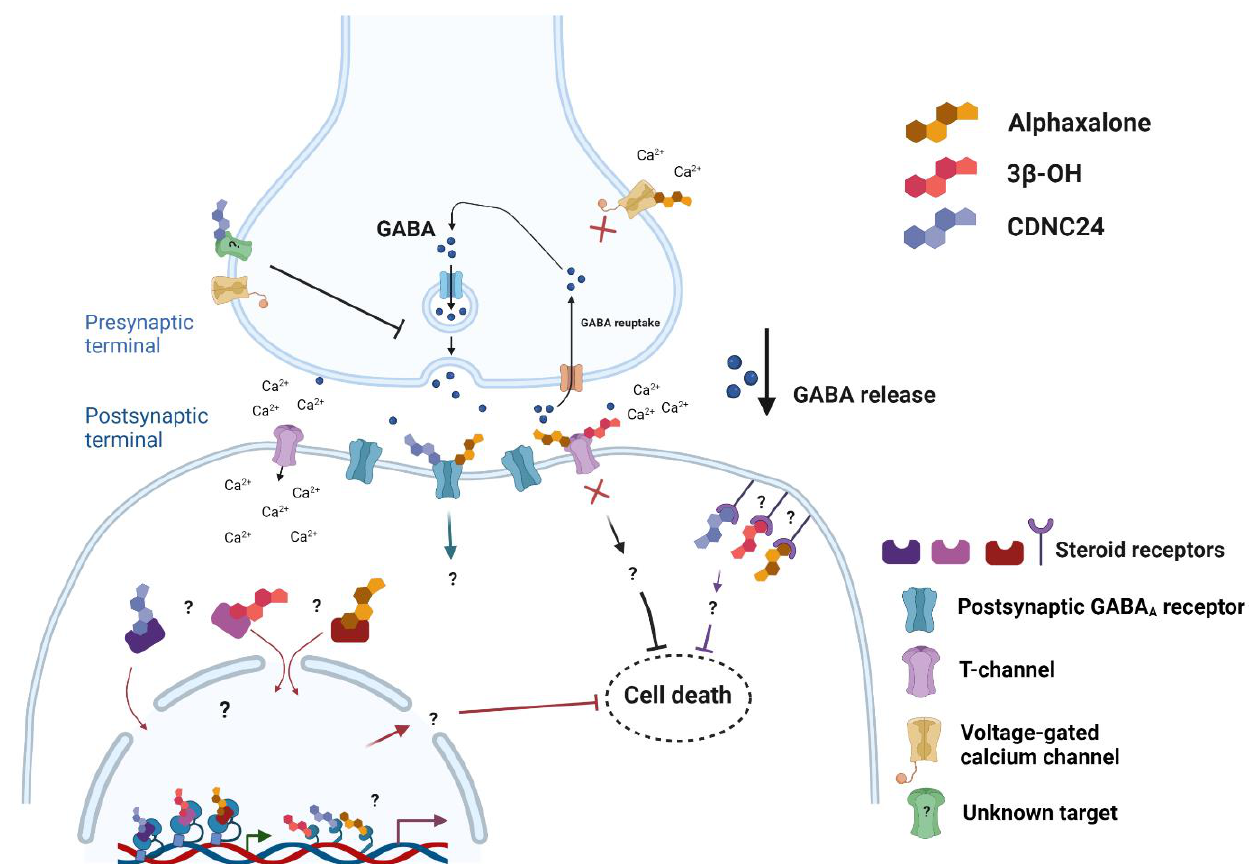
Figure 2. Summary of known and potential mechanisms of neuroactive steroids. 3 β -OH inhibits postsynaptic T-channels without having a direct effect on postsynaptic GABA A receptors. In addition to postsynaptic potentiation of GABA A , both CDNC24 and alphaxalone presynaptically reduce spontaneous GABA release, thus decreasing GABA content in the synaptic cleft. In addition to its effect on postsynaptic GABA A receptors and reduction in presynaptic GABA release in the synaptic cleft, alphaxalone also simultaneously blocks postsynaptic T-channels. Additionally, based on the well-known abilities of steroid compounds to pass cellular membranes, there is a possibility that the explanation for the absence of cell death in neurons lies in their direct or indirect interactions with membrane-bound, intracellular, and nuclear receptors, either as agonists or antagonists. These targets, as well other potential targets on the presynaptic terminal, remain unknown. At present, a causative link between electrophysiological and behavioral impairments and potentiation of GABAergic neurotransmitter systems has not been confirmed. It would be difficult to establish such a link, considering the fairly promiscuous nature of currently available general anesthetics, which are known to modulate other cellular targets (e.g., leak potassium channels, NMDA/AMPA subtypes of glutamate receptors, and glutamate excitatory amino-acid transporters (EAAT)-1/2/3) [1,27,31,85,86]. A unifying property